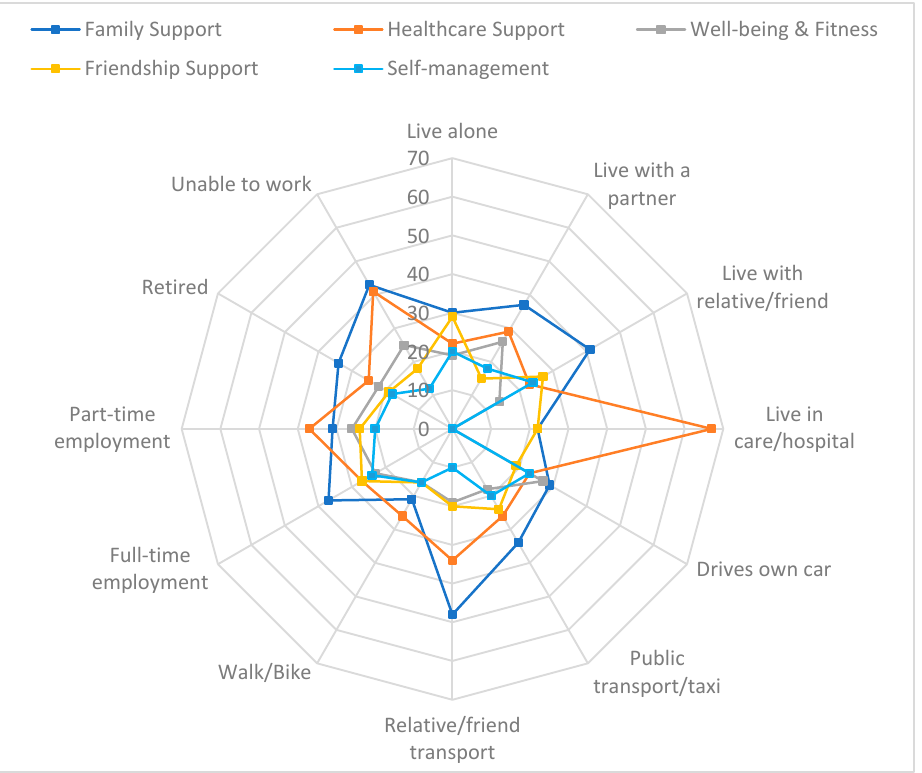
Figure 5. The three most reported facilitators to activity (%) at 6 month follow-up by participant’s living situation, transport use and employment status.